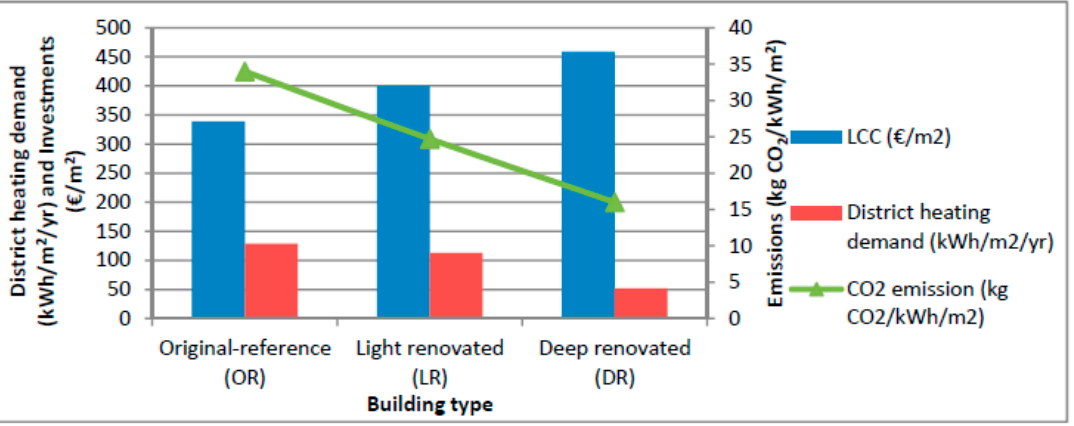
Figure 8. The annual heating demand of the buildings in the community, investment cost at the building level, and CO 2 emissions from the city-level district heating grid for the reference case (Case 0).